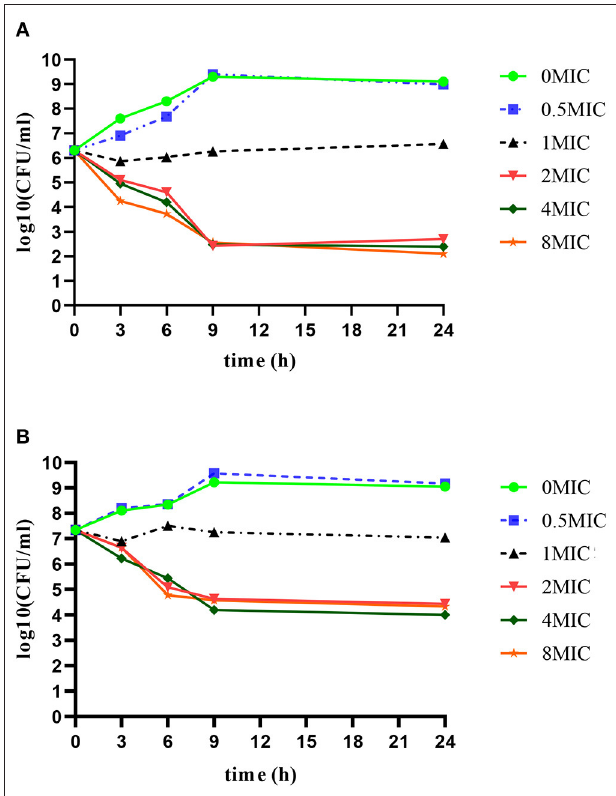
FIGURE 1 | In vitro time bactericidal curve of rifaximin against S. aureus Newbould305 with different initial bacterial load. (A) 106 CFU/ml initial inoculum group. (B) 107 CFU/ml initial inoculum